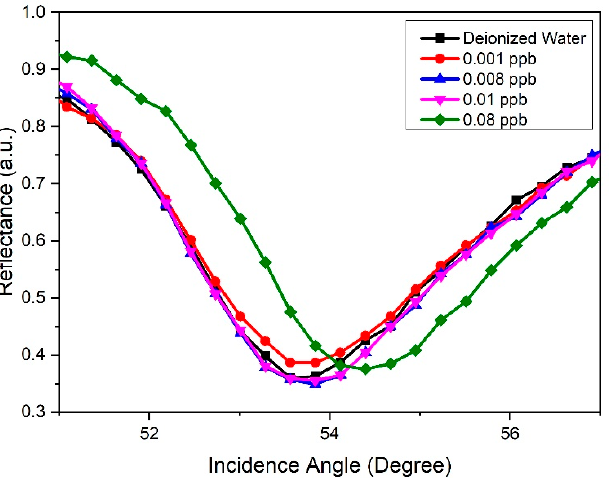
Figure 14. SPR reflectance curve as a function of incidence angle for GQDs-PVA thin film in the detection of different concentrations of carbaryl. Table 1. Comparison of this study with other carbaryl sensors using various materials in terms of limit of